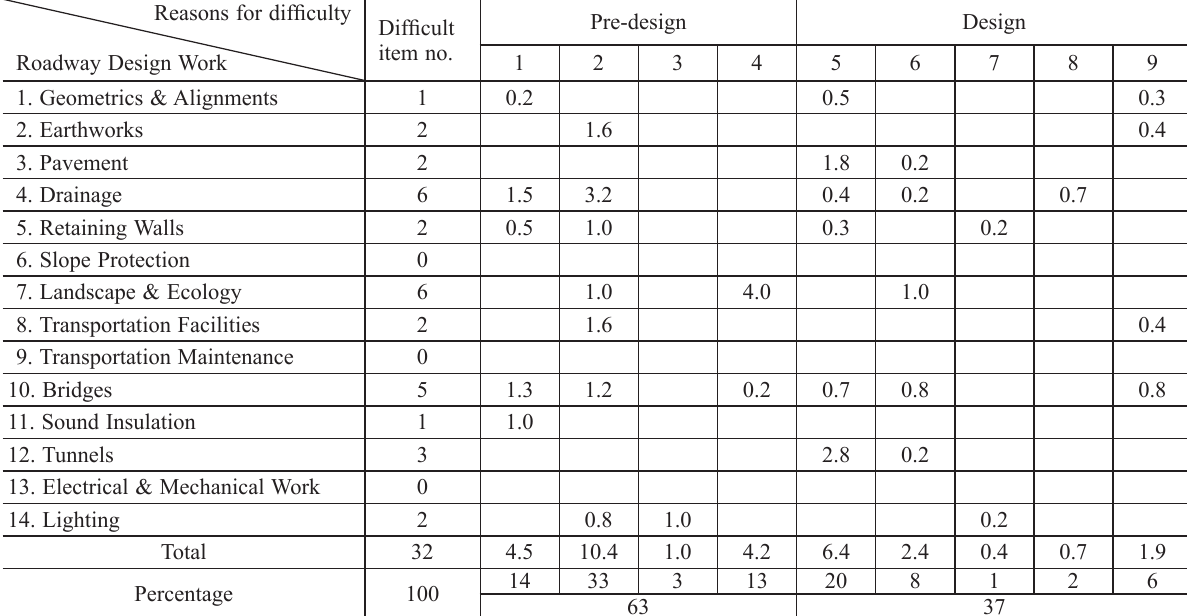
Table 5. Weights of difficulty reasons for sustainable roadway design Reasons for difficulty Roadway Design Work